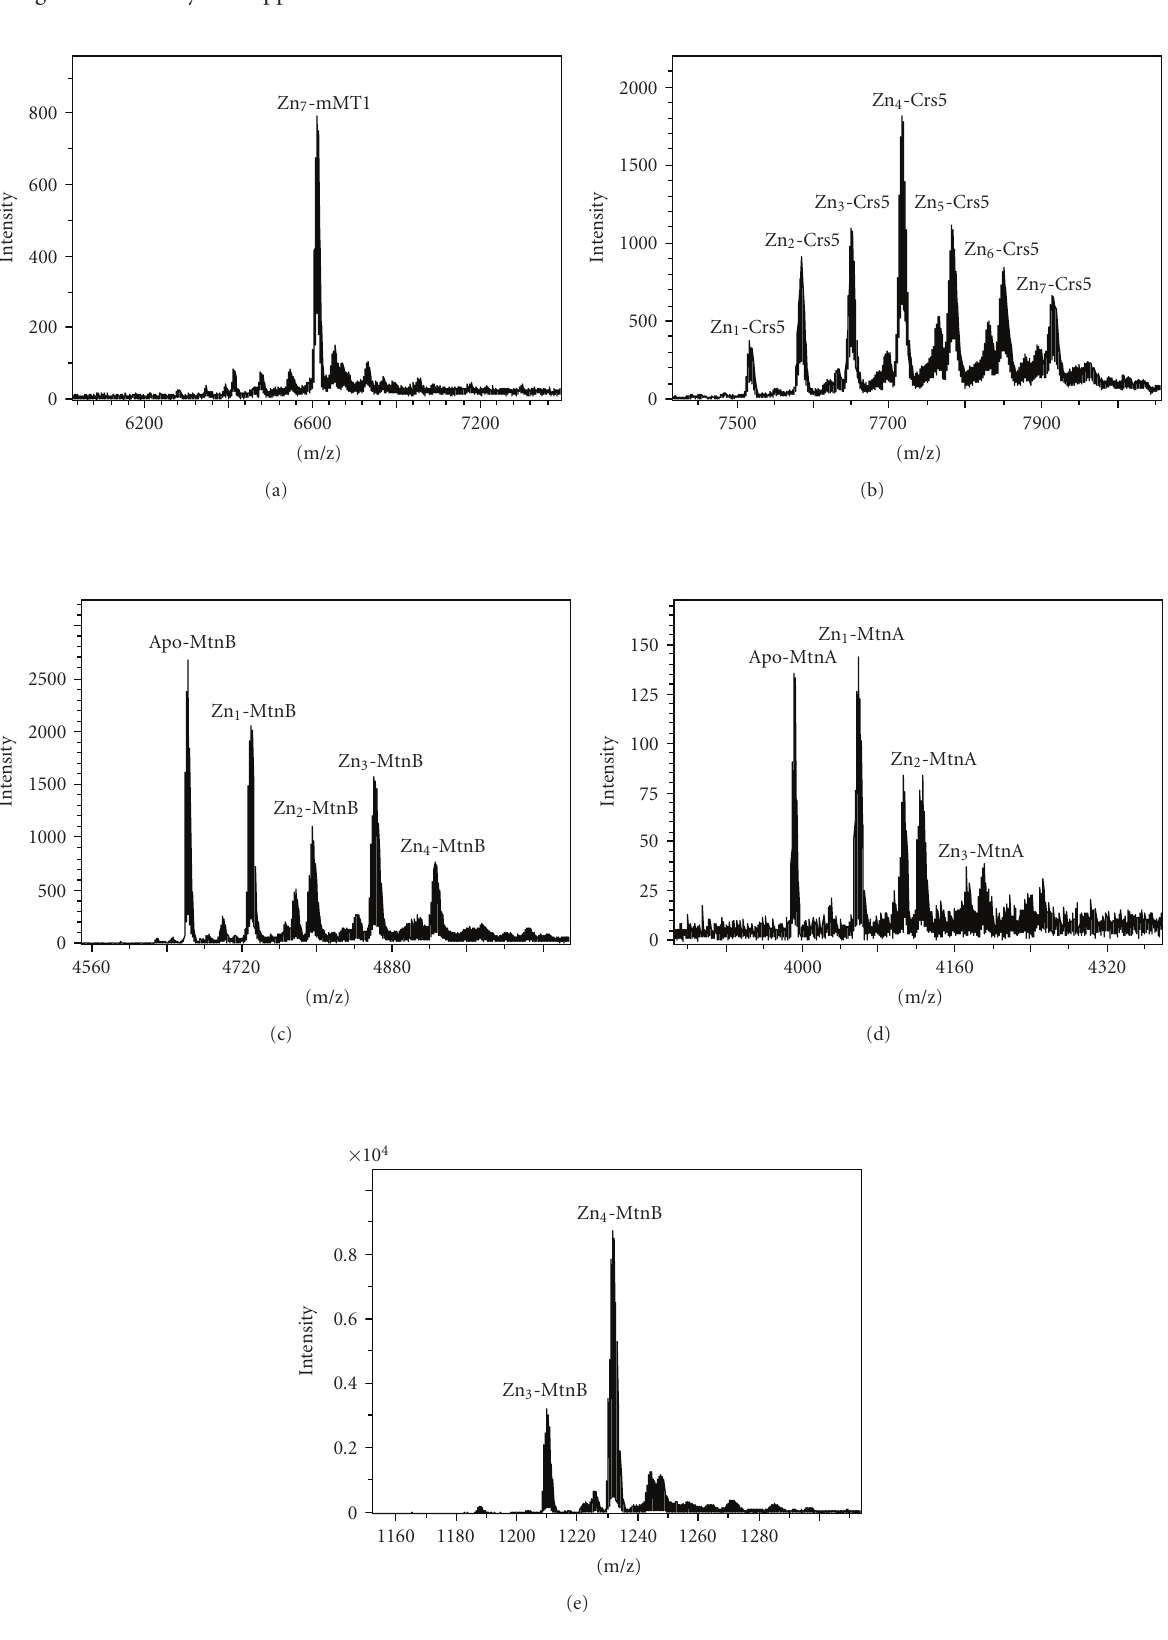
Figure 1: Deconvoluted ESI-TOF MS spectra of the recombinant Zn(II)-MT complexes obtained from the pGEX-MT expression system with no zinc supplementation to the culture: (a) mouse MT1; (b) yeast Crs5; (c) D. melanogaster MtnB and (d) D. melanogaster MtnA. (e) MtnB was also synthesized in zinc-enriched medium, to be used as a